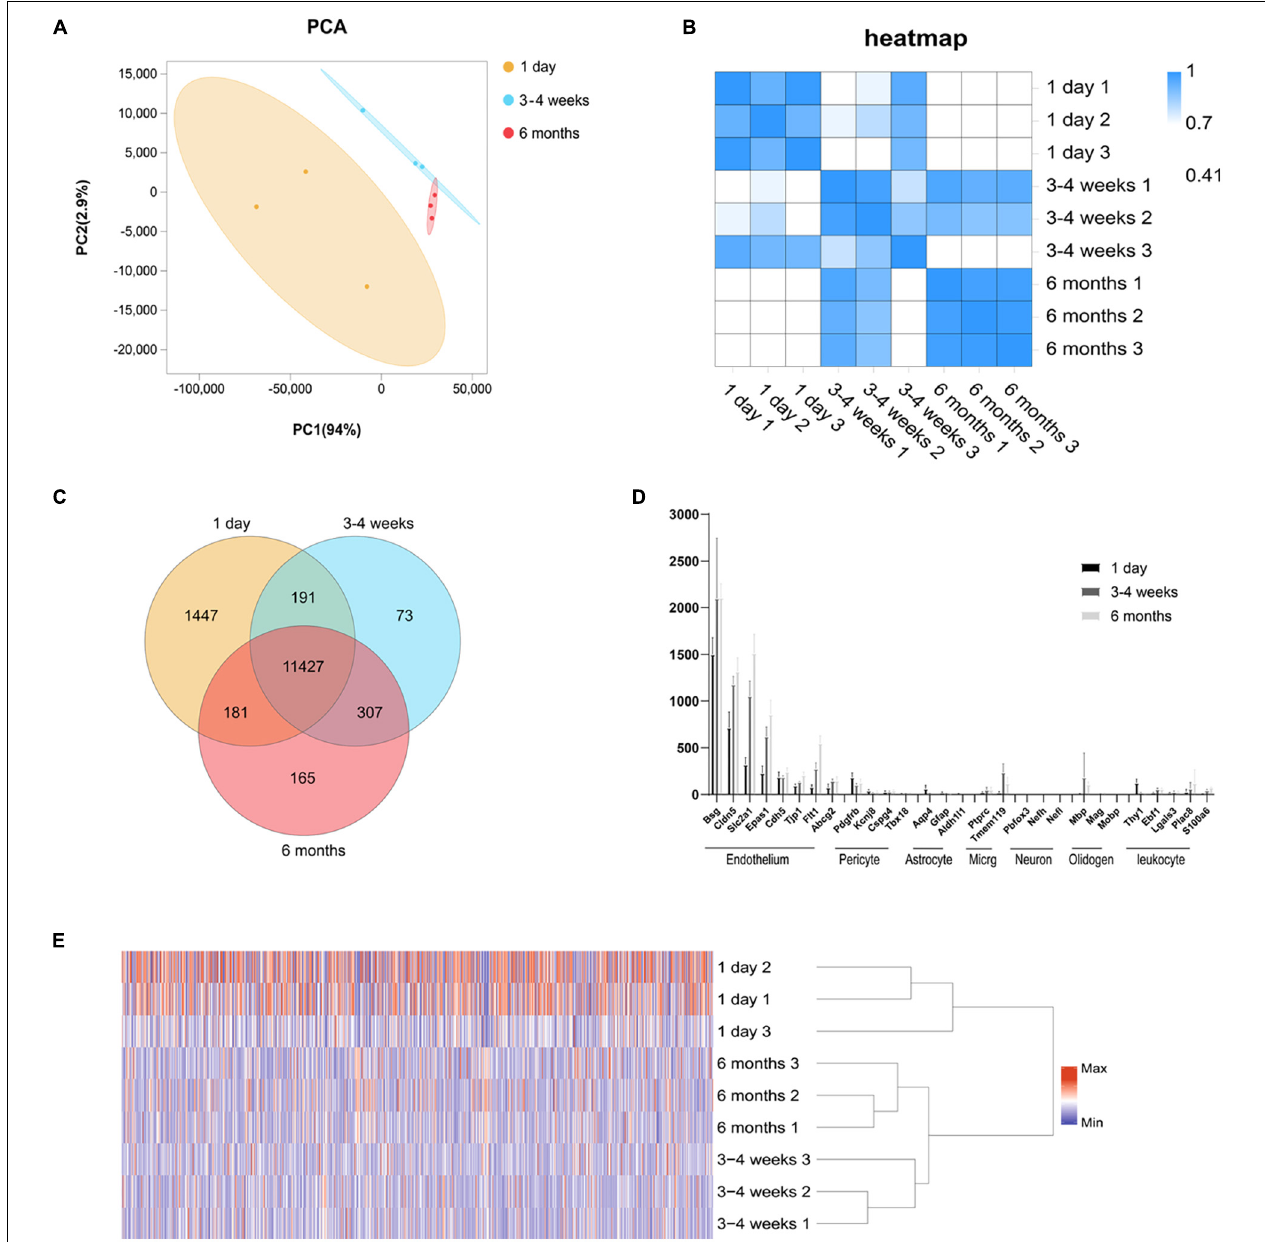
FIGURE 1 | Global gene expression profiling among three cerebral microvascular groups. (A) Principal component analysis (PCA) of RNA-seq data from three groups of brain microvessels. The percentage refers to the contribution of this principal component to the overall variance. The distance between the points reflects the difference between the samples they correspond to. (B) Transcript-based sample Pearson’s correlation analysis shows the transcript expression level correlation among neonatal (1-day-old), adolescent (3–4-week-old) and adult (6-month-old) groups. The abscissa indicates the sample name, the ordinate indicates the corresponding sample name, and the color indicates the correlation coefficient size. (C) Venn diagram of differentially expressed transcripts among three groups. (D) Comparison of the expression levels (FPKM) of endothelial cell markers and non-endothelial cell markers in endothelial cells enriched from microvessels of the brain. The brain vascular samples in 1-day-old (black bars), 3–4-week-old (gray bars) and 6-month-old (French gray bars) rats are enriched with RNA of markers for CNS endothelial cells but not enriched with RNA of markers for CNS pericytes, astrocytes, microglia (micrg), neurons, oligodendrocytes (oligoden) and leukocyte. (E) The heat map of cluster analysis shows the whole transcript expression levels among three cerebral microvascular groups. The color scale illustrates the relative expression levels across all samples: red represents an expression level above the mean, and blue represents an expression level lower than the mean. The dendrogram on the left of the heat map shows the clustering of the transcripts. Data are presented as mean ± SEM; n = 5–10 per group.